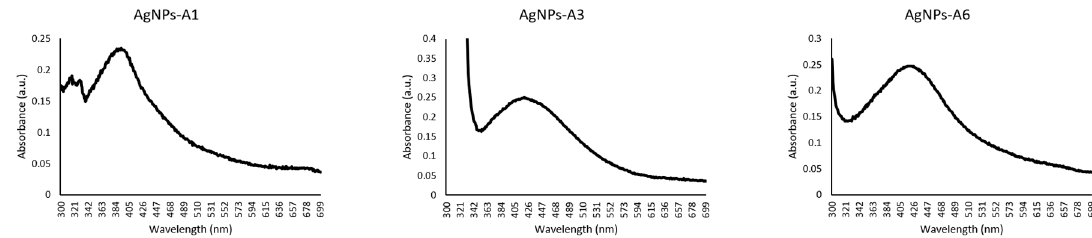
Figure 4. UV-visible spectrum of azoles after conjugation with silver nanoparticles. Peaks can be observed at around 400 nm, suggesting successful conjugation of drugs and nanoparticles.